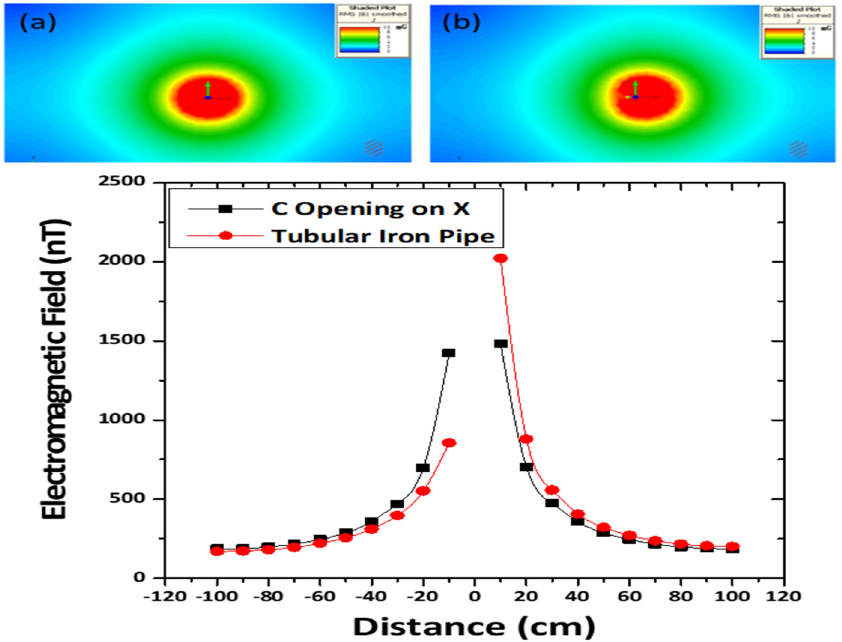
Figure 2. Electromagnetic field intensities emitted from the tubular structure without an opening ( a ) and the C-shape cylindrical device ( b ) by MagNet. ( c ) Electromagnetic field as a function of the distance.